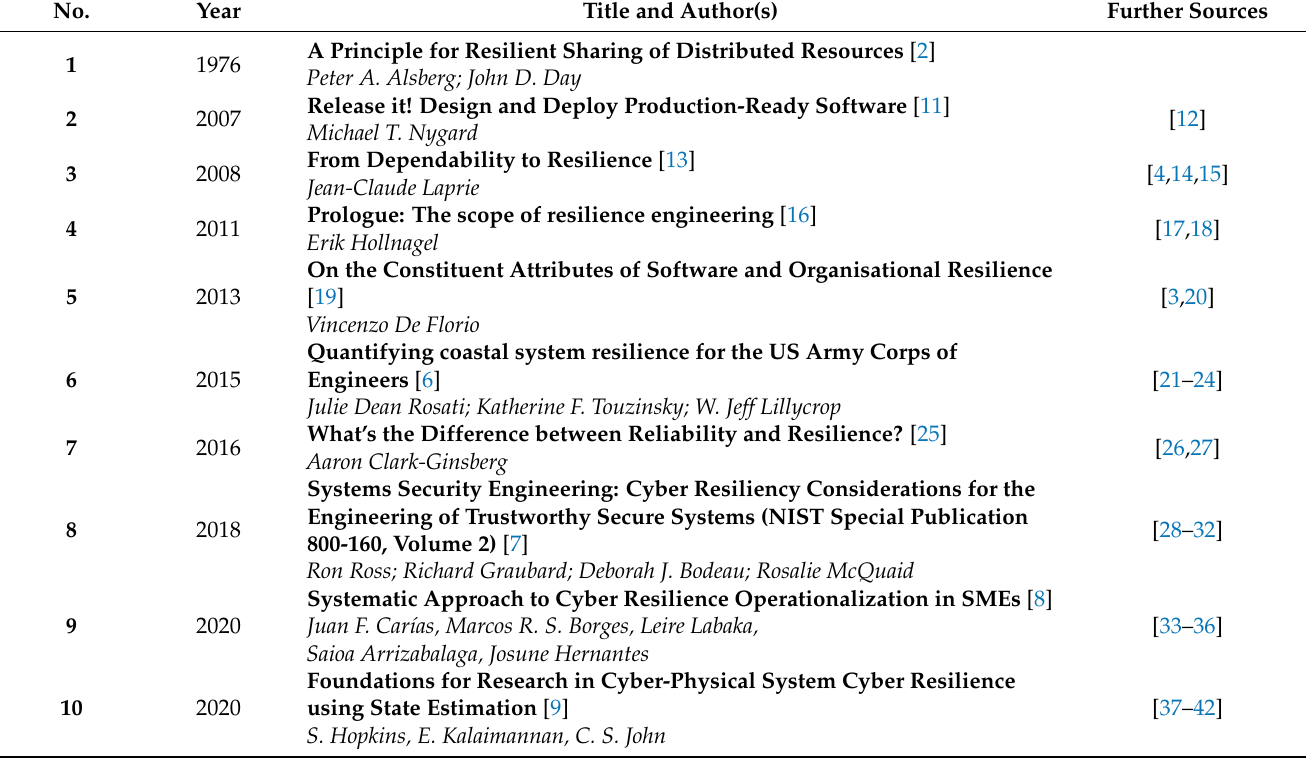
Table 1. The columns “title”, “author(s)”, and “year” show the papers we used as the main sources for this work, the column “further sources” indicates additional publications that use the term resilience in a similar way to the main source in the same